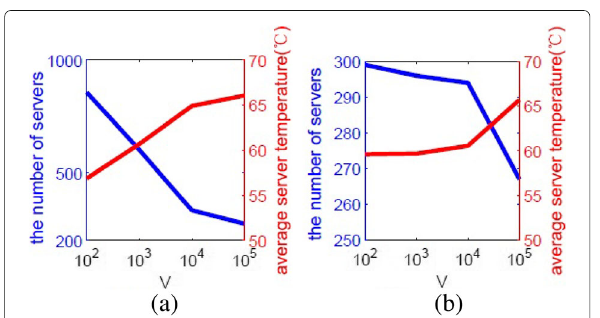
Fig. 9 The relationship between number of servers and average server temperature. a linear, b quadratic